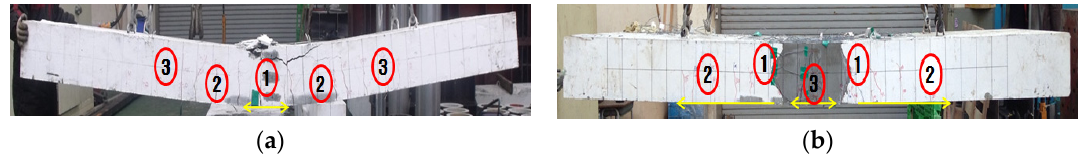
Figure 4. Crack progression: ( a ) integral specimen; ( b ) modular specimen.